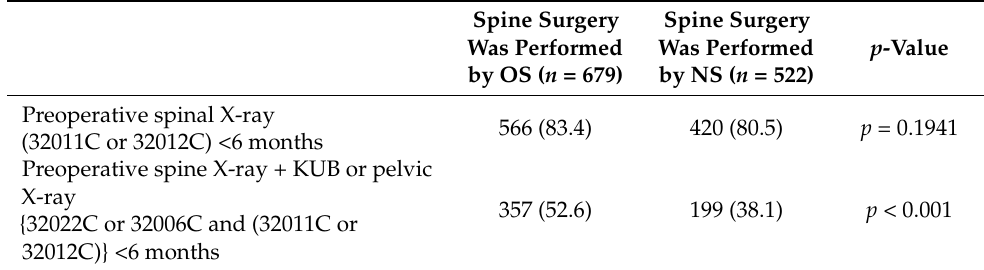
Table 6. Comparison of diagnoses of spinal or hip disorders. Spine-related diagnosis before surgery 491 (72.3) 415 (79.5) p = 0.0041